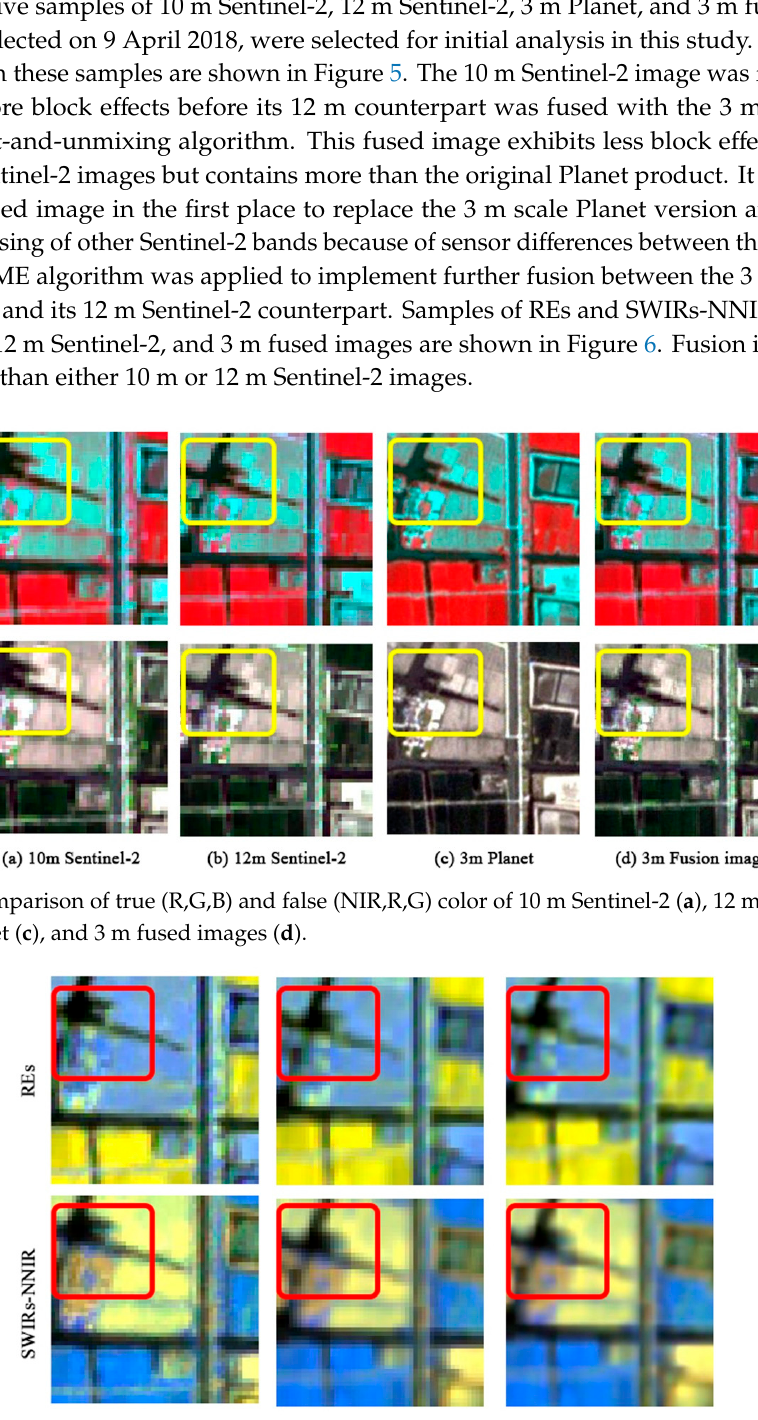
Figure 6. Comparison of REs (RE-3, RE-2,RE-1) and SWIRs-NNIR (SWIR-2, SWIR-1, Narrow NIR) 10 m Sentinel-2 ( a ), 12 m Sentinel-2 ( b ), and 3 m fused images ( c ).